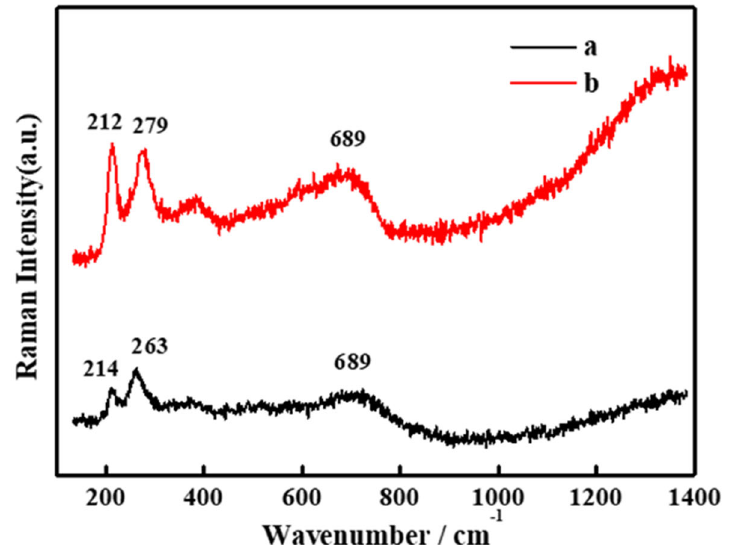
Figure 13. The Raman spectra of 304 stainless-steel samples after a 4 week immersion test in different solutions: (a) SG+ Na 2 SeO 3 ; (b) SG+ Na 2 SeO 4 .